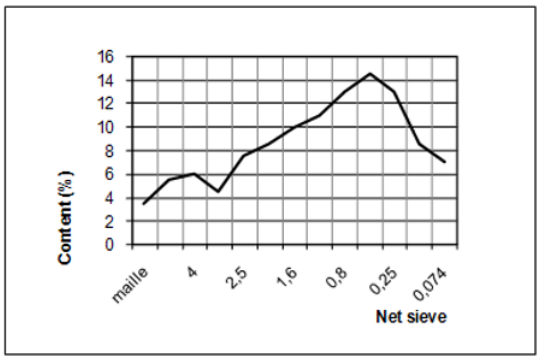
Fig. 2. Curve 2. Granulochimic analysis of